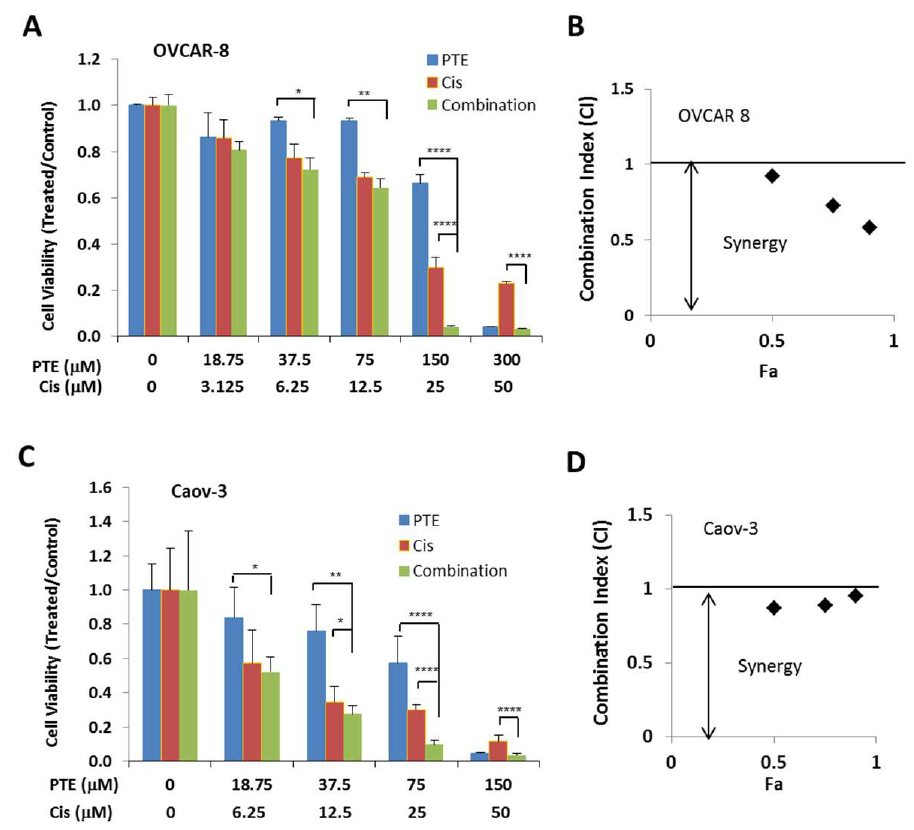
Figure 6. Pterostilbene enhances anti-tumor activity of cisplatin. OVCAR-8 ( A , B ) and Caov-3 ( C , D ) cells were treated with cisplatin and PTE either alone or in a combination at various concentrations in a fixed molar ratio. Cell viability was determined 48 h later ( A , C ). Data are expressed as the ratio to control treated with vehicle (DMSO). ( B , D ) Combination Index (CI) values. CI values in black diamond were determined by Chou-Talalay method using the Calcusyn software.Results are representative of 3 or more experiments, each with 3 or more replicates. *, p < 0.05, **, p < 0.005, ****, p < 0.0001, versus control treated with vehicle.